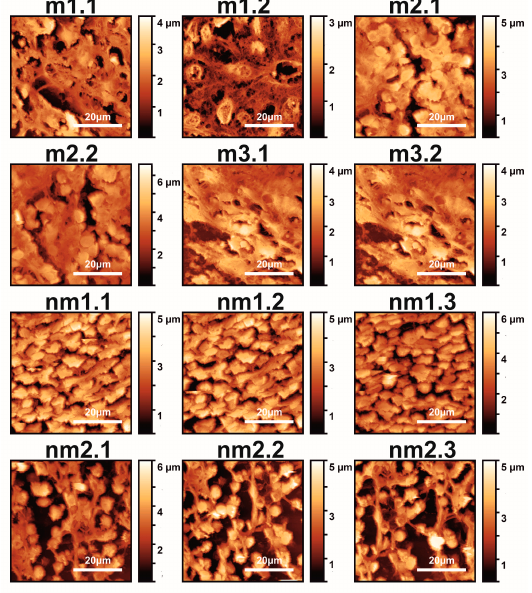
Figure 1. AFM images (12 images shown out of 18 total) of metastatic (m1.1–m3.2) and non-metastatic (nm1.1–nm2.3) human CRC histological sections. The first and second numbers refer to the patient and sample, respectively (m and nm belong to five patients). The colour bar in the vertical y -axis represents the z -heights of the image area.